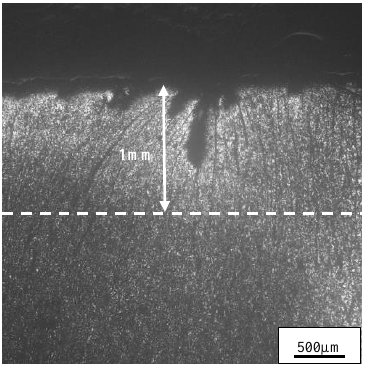
Figure 5. Surface decarburization layer in crack source area .